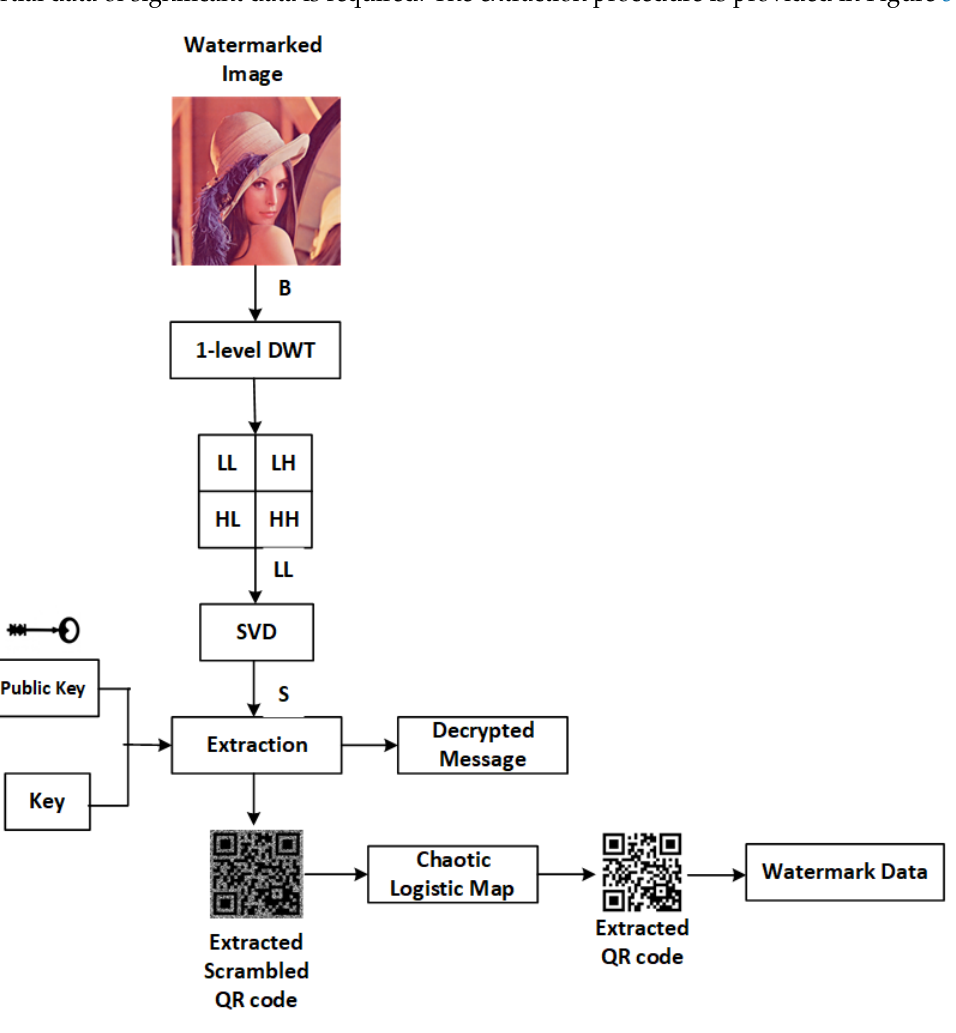
Figure 5. The proposed scheme: extraction process.